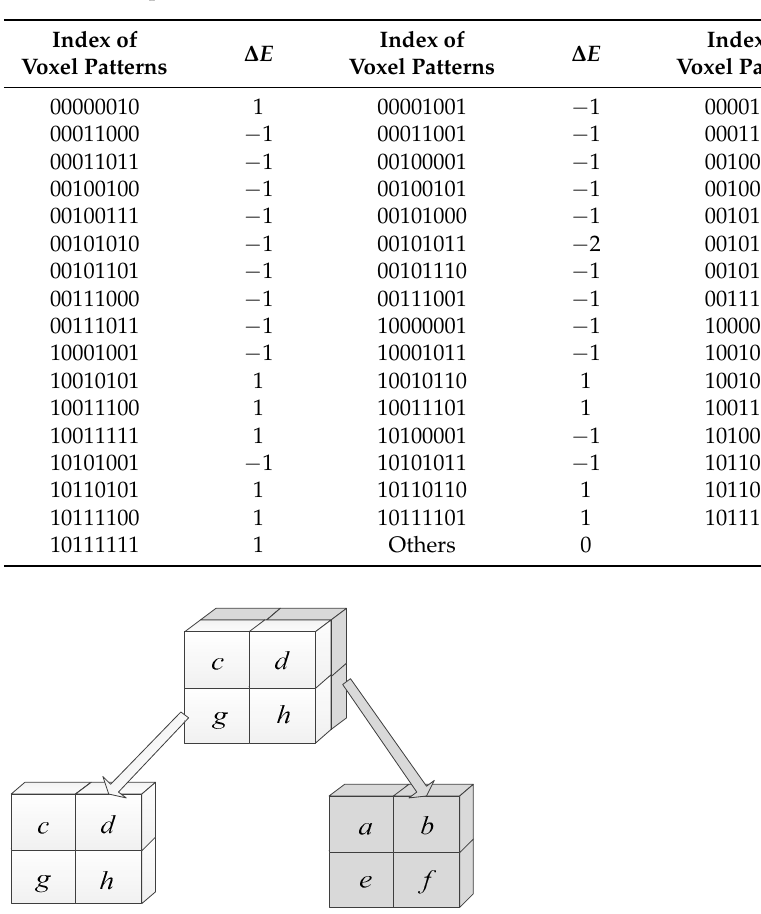
Figure 3. Distribution of voxels in a voxel pa tt ern. Table 1. Voxel pa tt erns’ indexes and their Euler number increments.